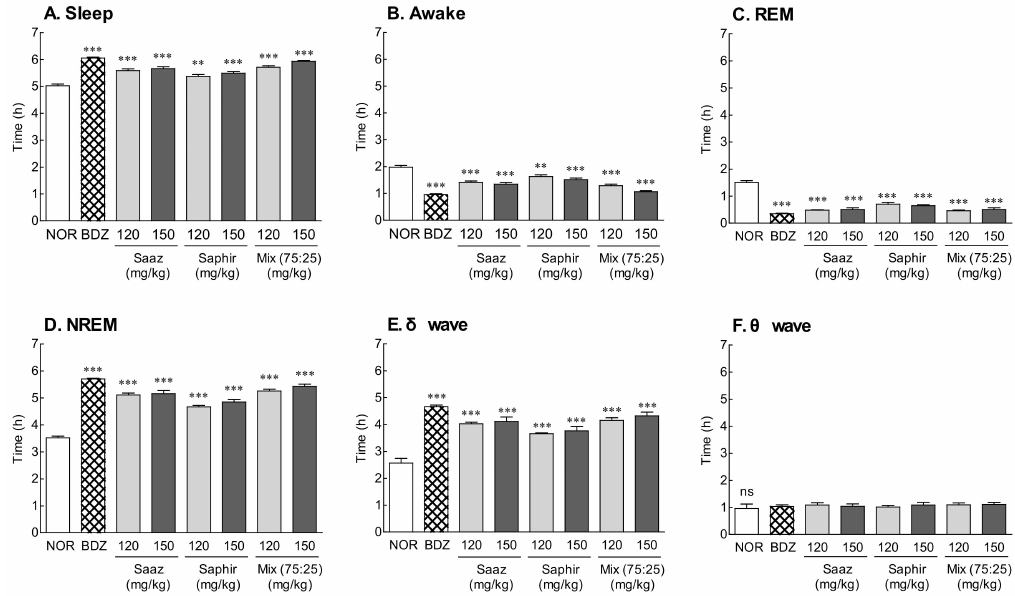
Figure 2. Effects of hops (Saaz, Saphir, and Saaz–Saphir mixture) on the electrophysiologic pattern in rats. Electroen- cephalography (EEG) analyses were conducted for 9 days. ( A ) Sleep time, ( B ) awake time, ( C ) duration of REM, ( D ) duration of NREM, ( E ) δ wave of NREM, and ( F ) θ wave of NREM. NOR: the 0.9% NaCl (physiological saline) group (normal group), BDZ: benzodiazepine treatment (positive control, 200 µ g/kg), Saaz (120 and 150 mg/kg), Saphir (120 and 150 mg/kg), and the Saaz–Saphir mixture (75:25, 120 and 150 mg/kg). Values are presented as the mean ± standard error of the mean (SEM) for each group, n = 8. Asterisks indicate significant differences: ** p < 0.01, and *** p < 0.001 vs. NOR by Tukey’s multiple comparison test. NS, not significant.